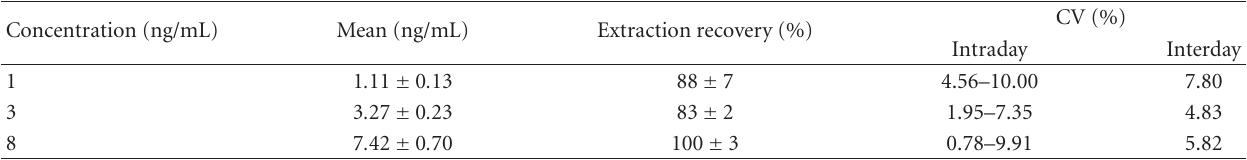
Table 2: Recovery and precision for digoxin in spiked whole blood samples.